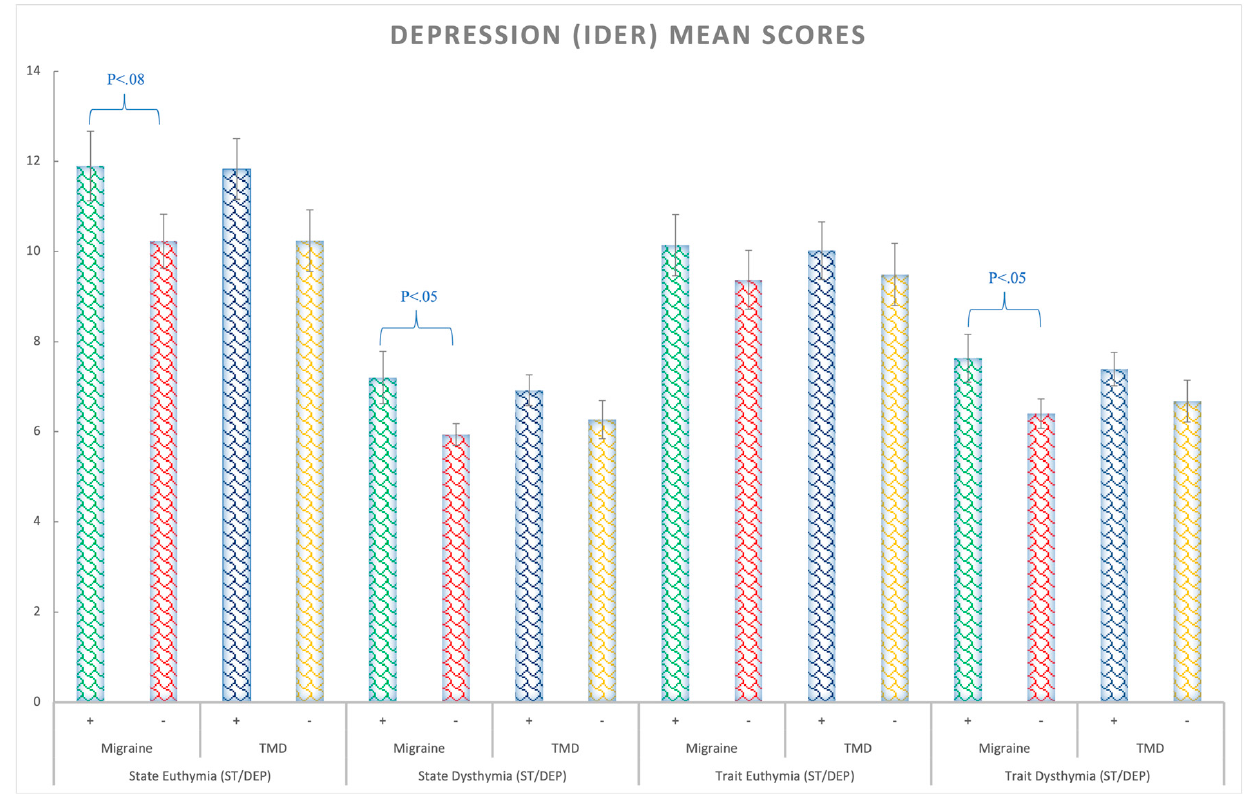
Figure 2. Depression (IDER) mean scores for the euthymia (similar to anhedonia) and dysthymia (negative mood, thoughts, and feelings) state and trait subscales considering the Migraine (+, − ) and TMD (+, − ) Factors. Bars represent standard errors.